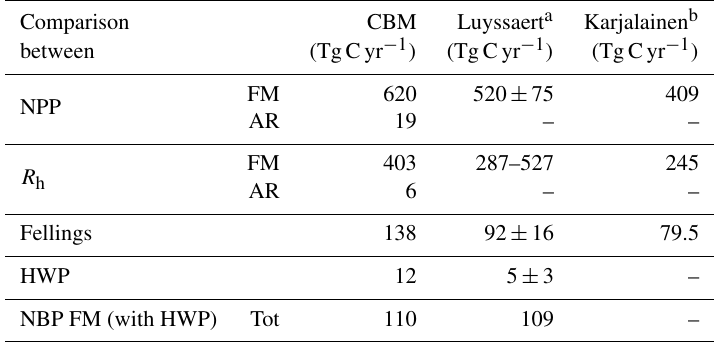
Table 3. Assumptions and main parameters for the model scenarios, compared with figures from Luyssaert et al. (2010) and Karjalainen et al. (2003). FM: forest management area, i.e., area of the existing forests in 1990. AR: afforestation and reforestation that has occurred since